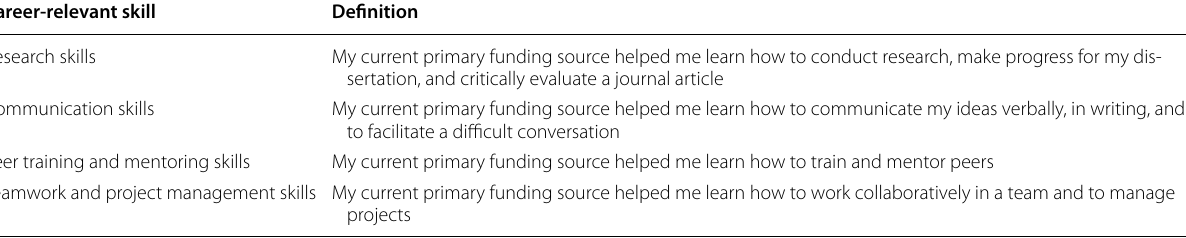
Table 1 Definitions of career-relevant